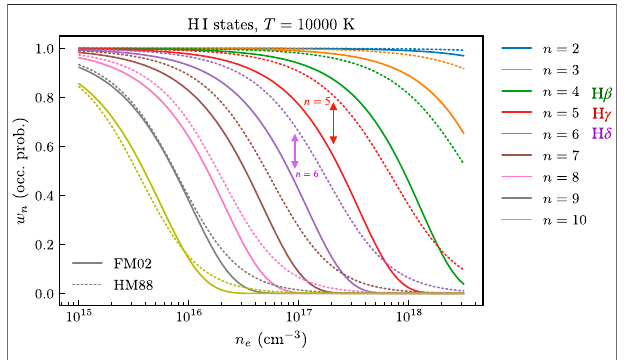
FIGURE 5 | The occupation probability of given energy levels n as a function of the electron number density. The solid curves give the OP of the FM02 formalism whilethedottedcurvesarethoseoftheHM88formalism.For n ≤ 8, the FM02 OP is less than that of HM88. FIGURE6| Themicro fi elddistributionproducedby Xenomorph ,fordifferent